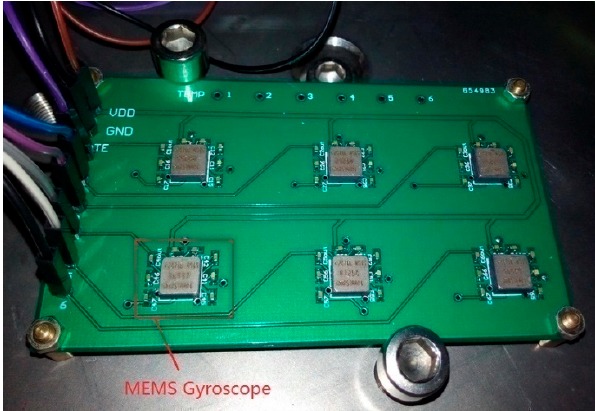
Figure 4. Prototype of the gyro array.